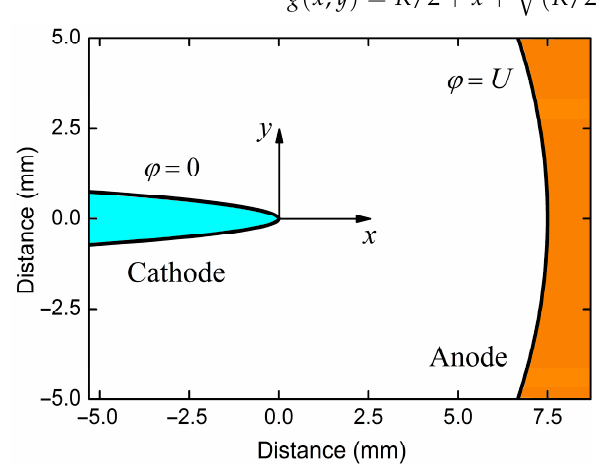
Figure 1. Model geometry of the interelectrode gap for R = 50 μ m and D = 7.5 mm.